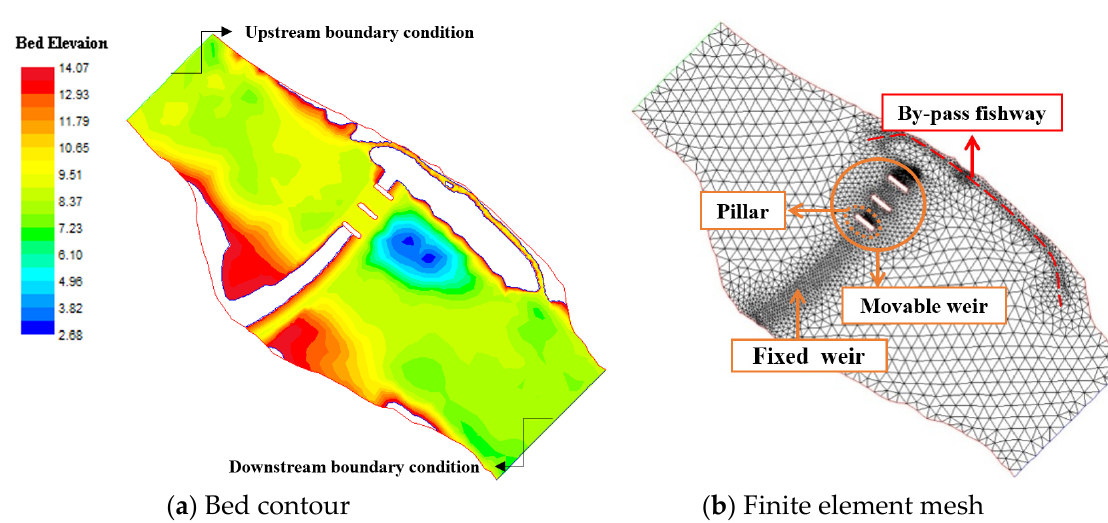
Figure 2. River bed contour and finite element mesh for study area.